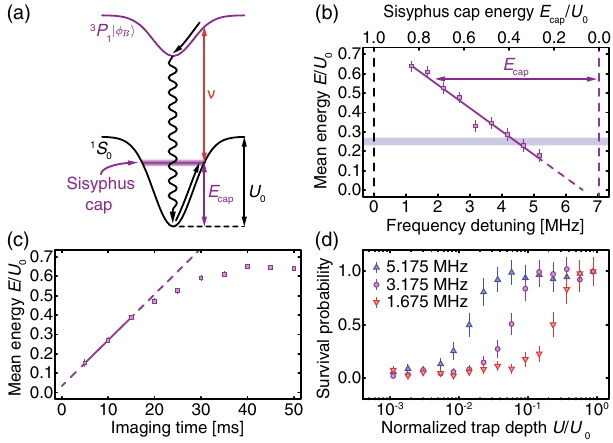
FIG. 4. Sisyphus cooling. (a) Diagram illustrating the mecha- nism of Sisyphus cooling on the 1 S 0 ↔ 3 P 1 j ϕ transition in the B i regime where the excited state is less trapped than the ground state. The red cooling beam at frequency ν is blue detuned away from free-space resonance, effectively creating a resonance condition for ground-state atoms with energy E . During cap fluorescence imaging, atoms are heated up until their energy reaches the Sisyphus cap, at which point they are excited and preferentially decay back to the ground state with lower motional energy. (b) Mean equilibrium energy of the atom after fluores- cence imaging, as a function of the Sisyphus detuning. The solid line is a linear fit to the experimental data. The shaded region represents the equilibrium energy after fluorescence imaging with sideband cooling instead of Sisyphus cooling. (c) Mean equilibrium energy of the atom versus imaging time for a Sisyphus detuning of 1.2 MHz. The energy initially increases linearly (solid line, t ≤ 15 ms) and later saturates. (d) Survival probability versus normalized final trap depth after adiabatically ramping down the trap depth, for various Sisyphus cap energies (Appendix